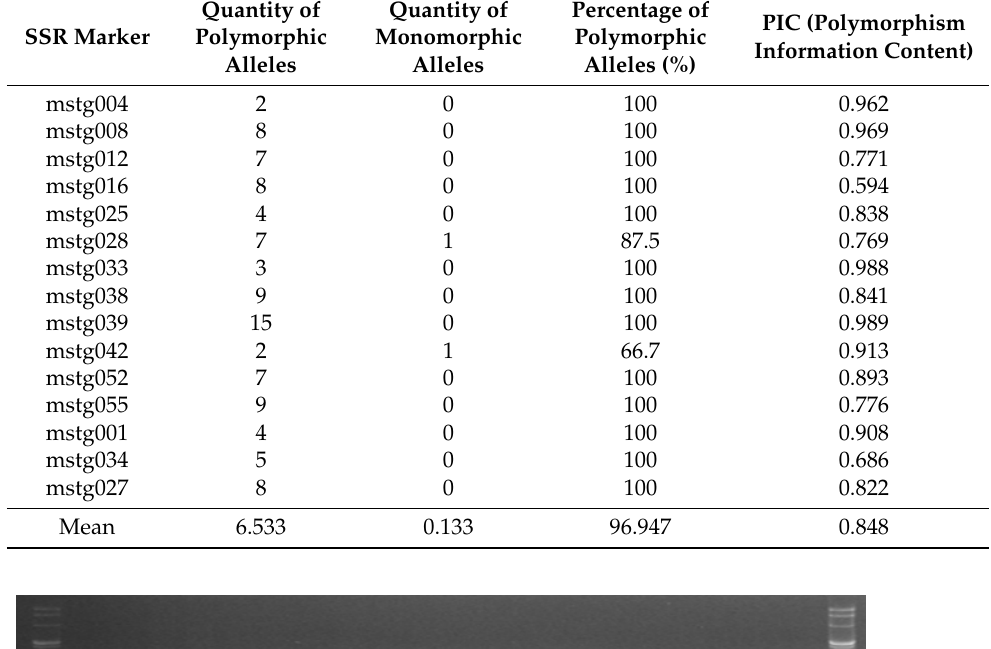
Table 3. Quantity of detected alleles and PIC values for SSR markers.